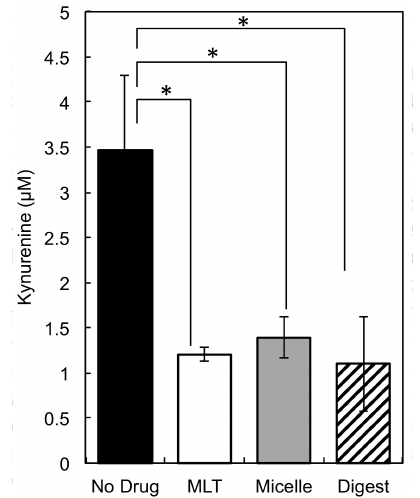
Figure 8. Concentration of kynurenine (KYN) in supernatant of THP-1 human monocytes after 24 h treatment with lipopolysaccharide (LPS) and MLT, micelles or chymotrypsin digested P(MLT). Data shown as the mean ± S.D. ( n = 3). * p < 0.01 determined by Student’s t